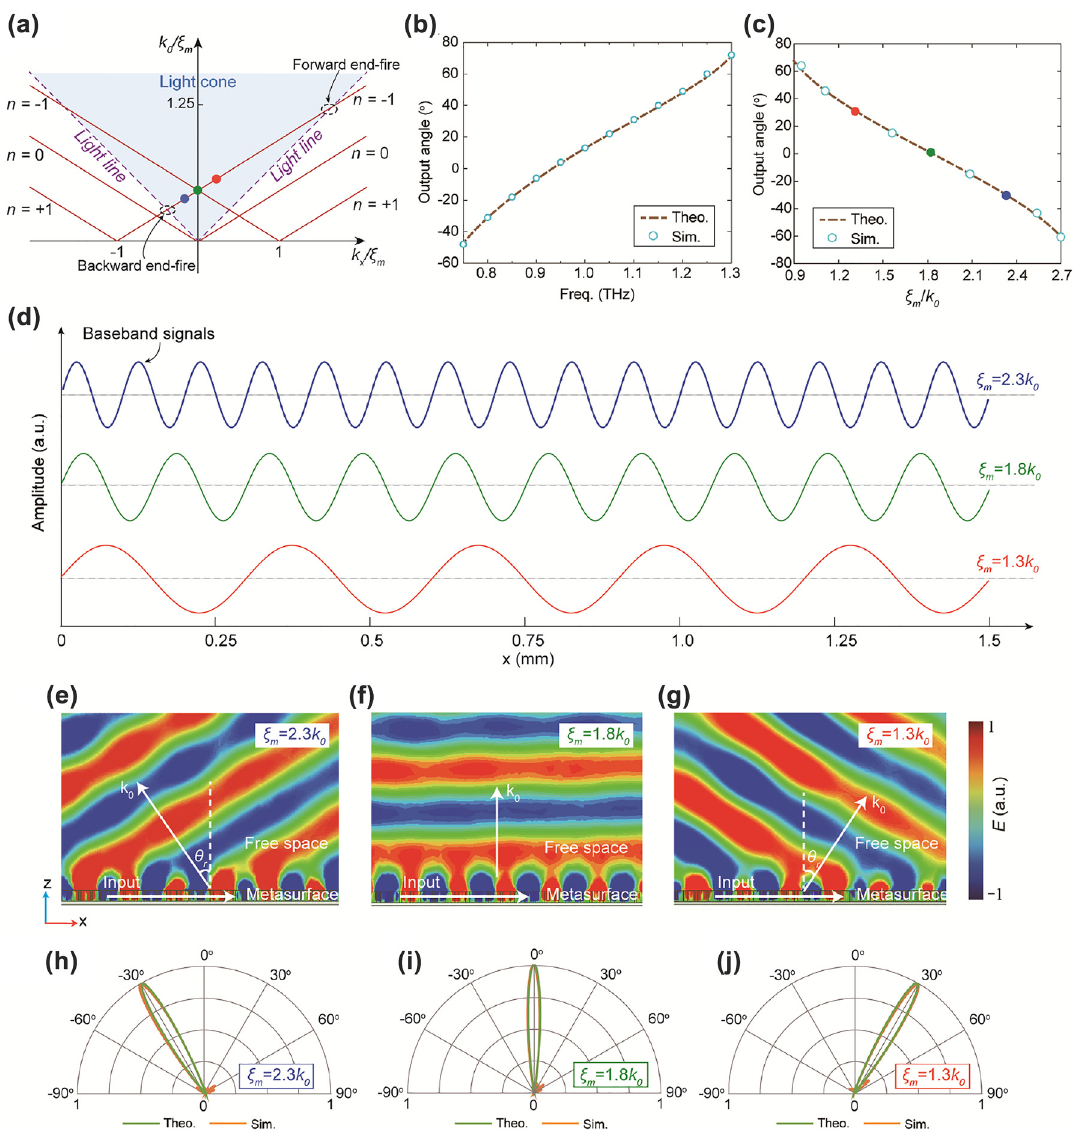
Figure 3: Agile beam deflection. (a) Brillouin diagram of the superheterodyne metasurfaces for agile beam deflection via changing the baseband spatial frequency or operating frequency. (b) Output beam angle versus the operating frequency when the baseband spatial = 3.34 × 10 4 rad ∕ m. The dashed line and the dots depict the theoretical and simulated data, respectively. (c) frequency is fixed as 𝜉 m Output beam angle versus the normalized baseband spatial frequency at 1 THz. The dashed line and the dots represent the theoretical and simulated data, respectively. (d) The waveforms of the baseband signals with different spatial frequencies 𝜉 which corresponds to the blue, green, and red dots in (a) and (c), respectively. (e to g) Simulated electric field distributions of the superheterodyne metasurfaces modulated by different frequencies of the baseband signals 𝜉 respectively. (h–j) Theoretical and simulated scattering patterns for the superheterodyne metasurfaces modulated by different frequencies = 2.3 k , 1.8 k , and 1.3 k at 1 THz, of the baseband signals 𝜉 0 0 0 m